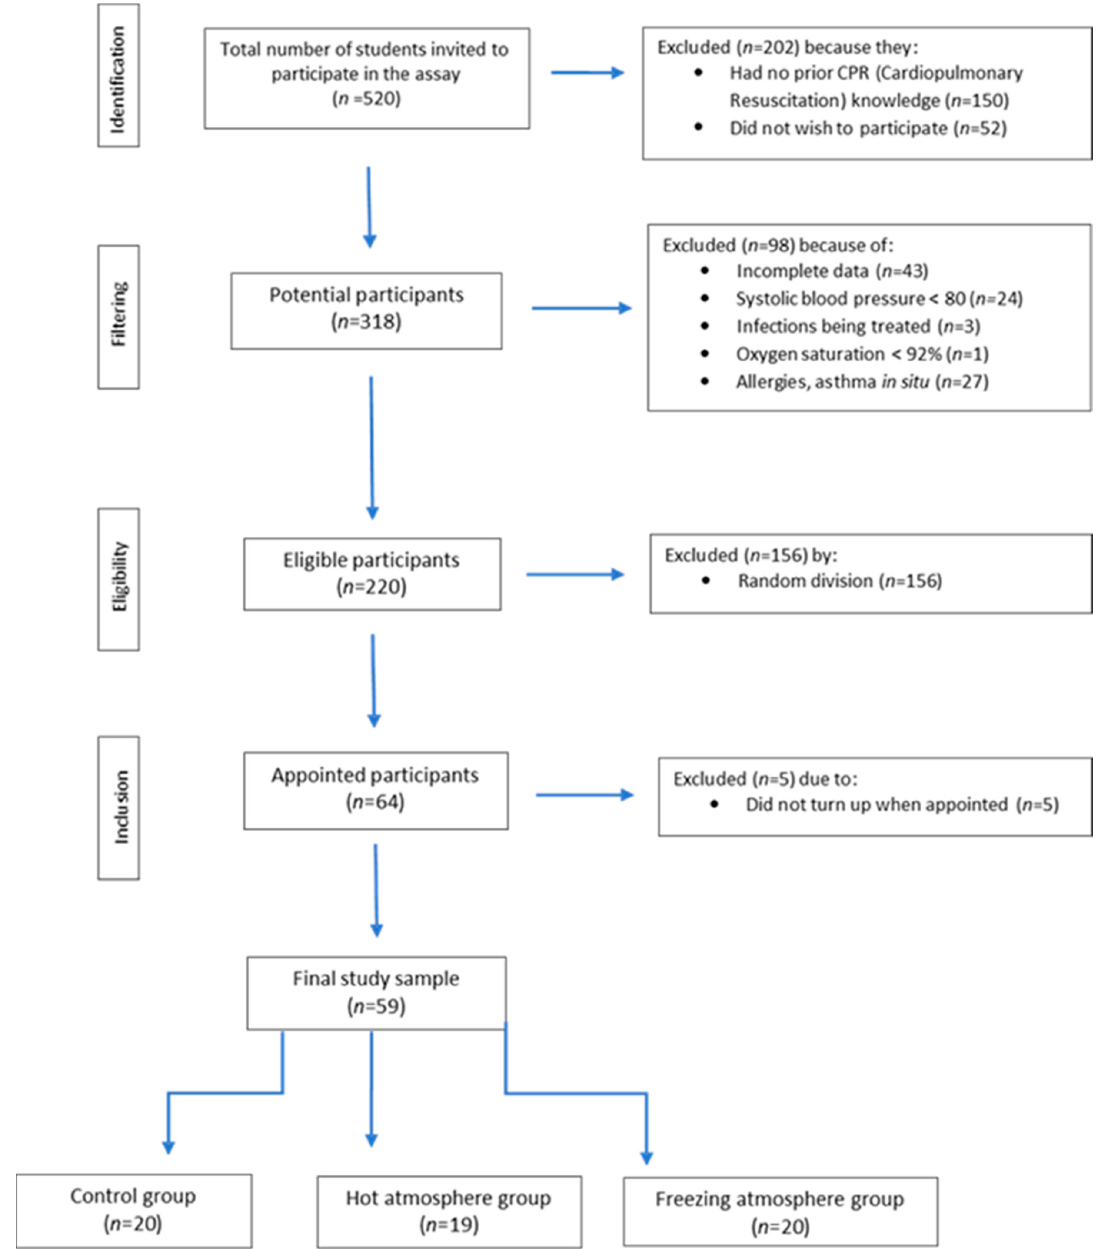
Figure 1. Flow chart of the selection of participants for this study.